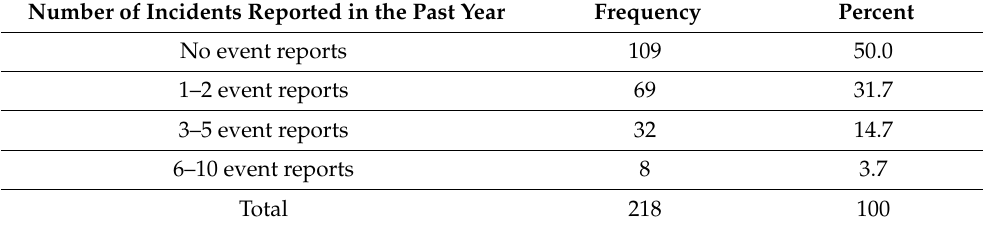
Table 3. Number of events